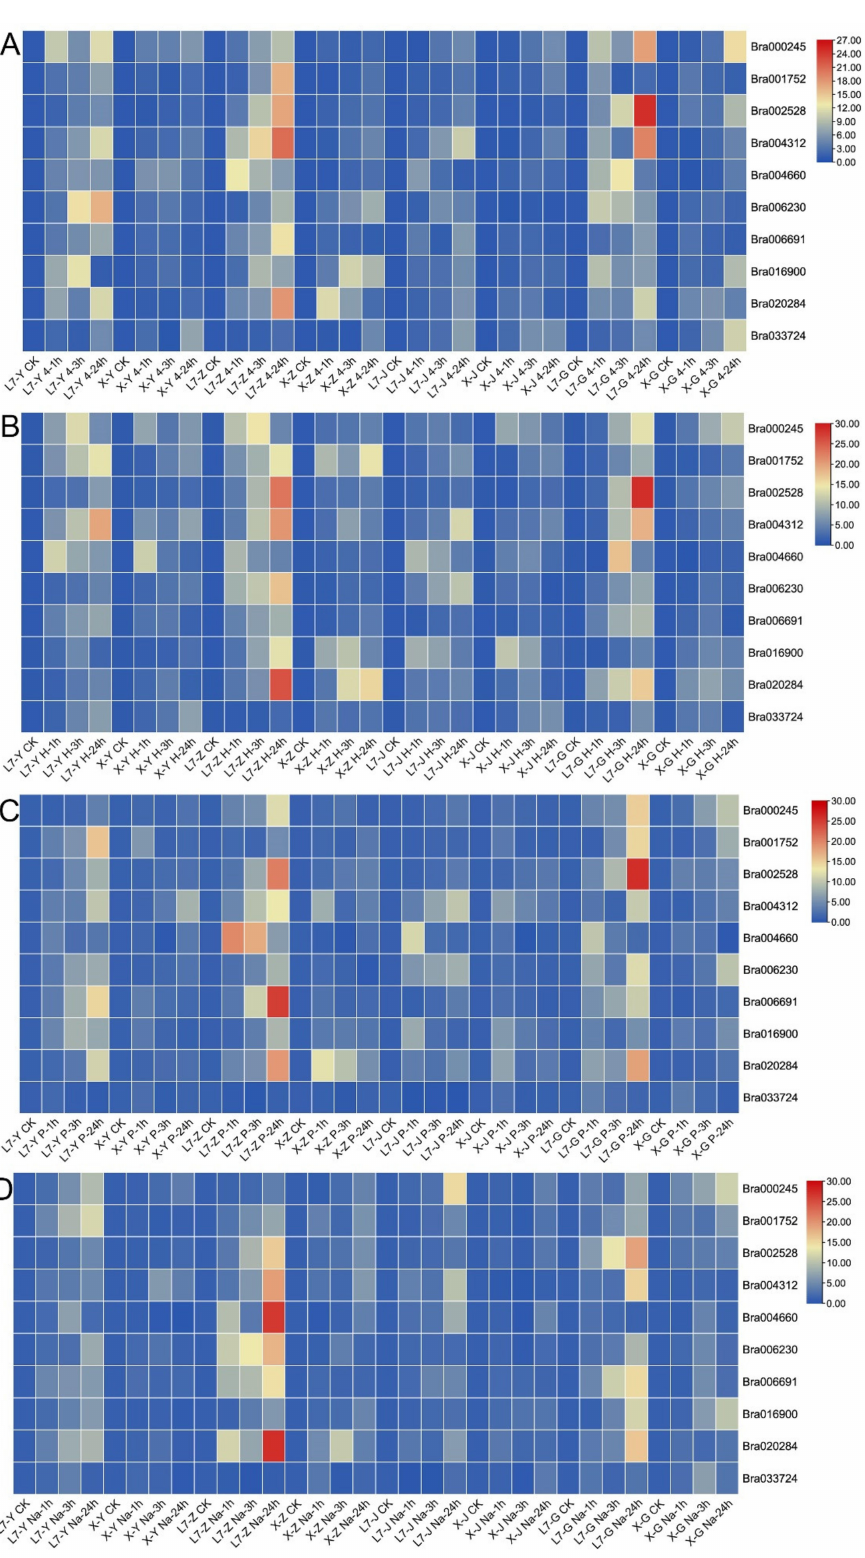
Figure 6. Heatmap of the expression of C2H2 ZFP genes in B. rapa under abiotic stress. ( A – D ) represent cold, high temperature, drought, and salt stress, respectively. Y, Z, J, and G in the column labels represent leaf, growth cone, stem, and root tissues of rapeseed,